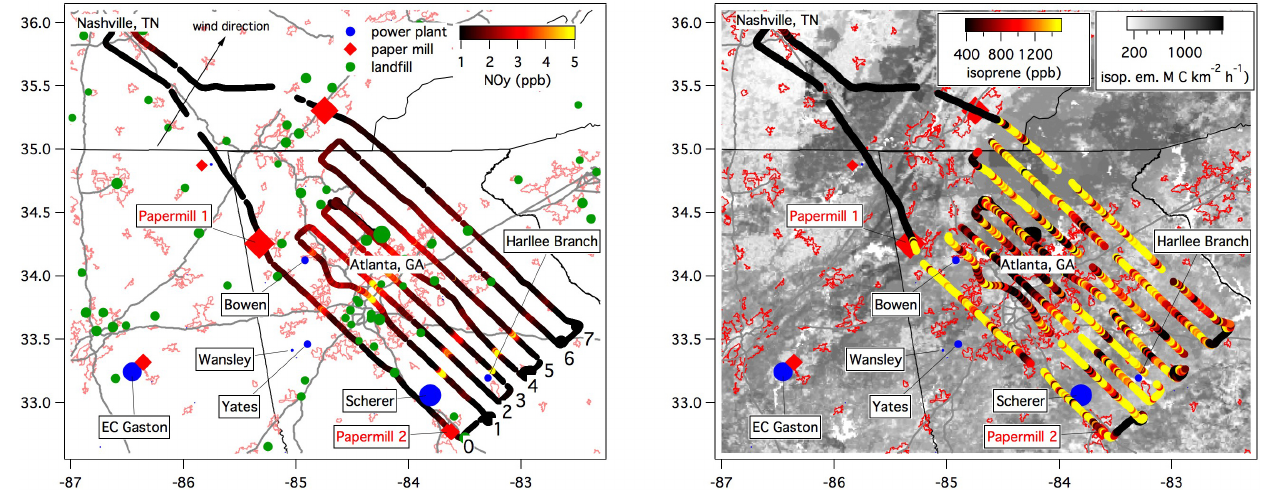
Figure 9. The flight track of the NOAA WP-3D on 16 June 2013 over Atlanta, GA color coded with NO y in the top panel and with isoprene on the bottom panel. The underlying maps show the point source emissions (power plants, paper mills and land fills) in the top panel and the isoprene emissions potential in the bottom panel.